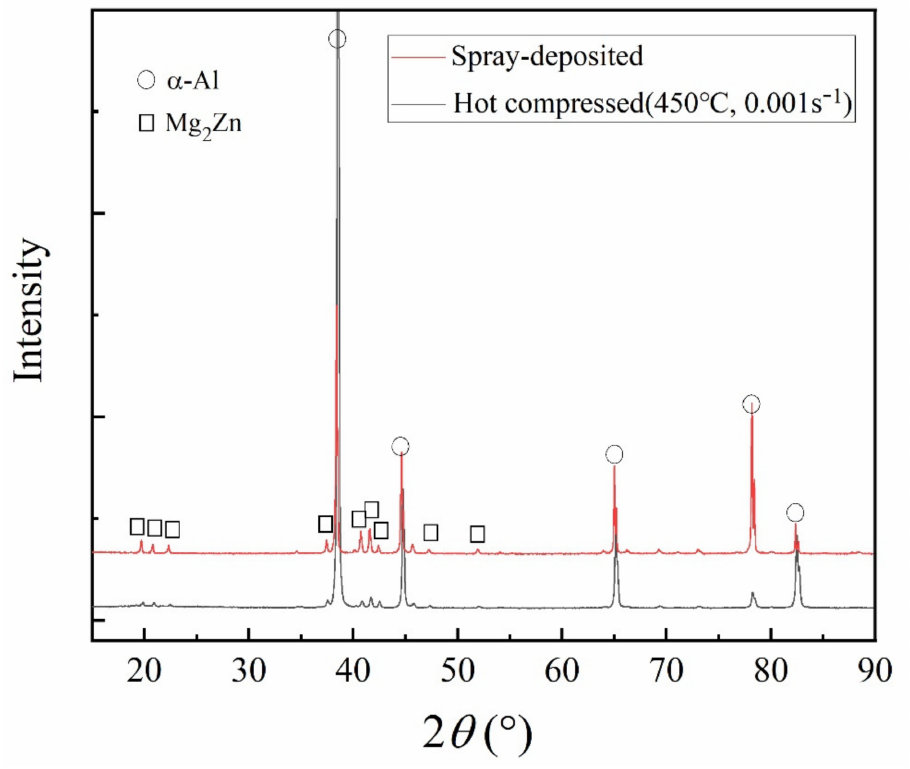
Figure 4. The XRD patterns of the spray-deposited specimen and the one deformed under 450 ◦ C/0.001 s − 1 ,